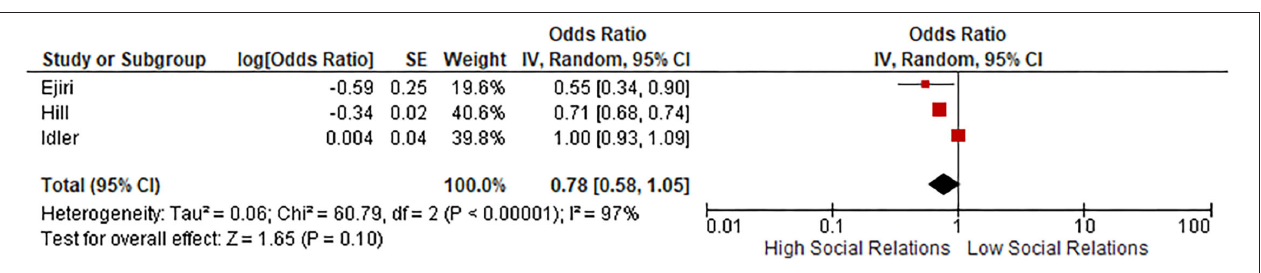
FIGURE 9 | Z-scores for social relations.